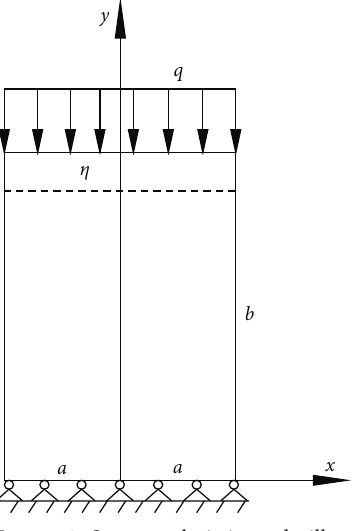
Figure 3: Stress analysis in coal